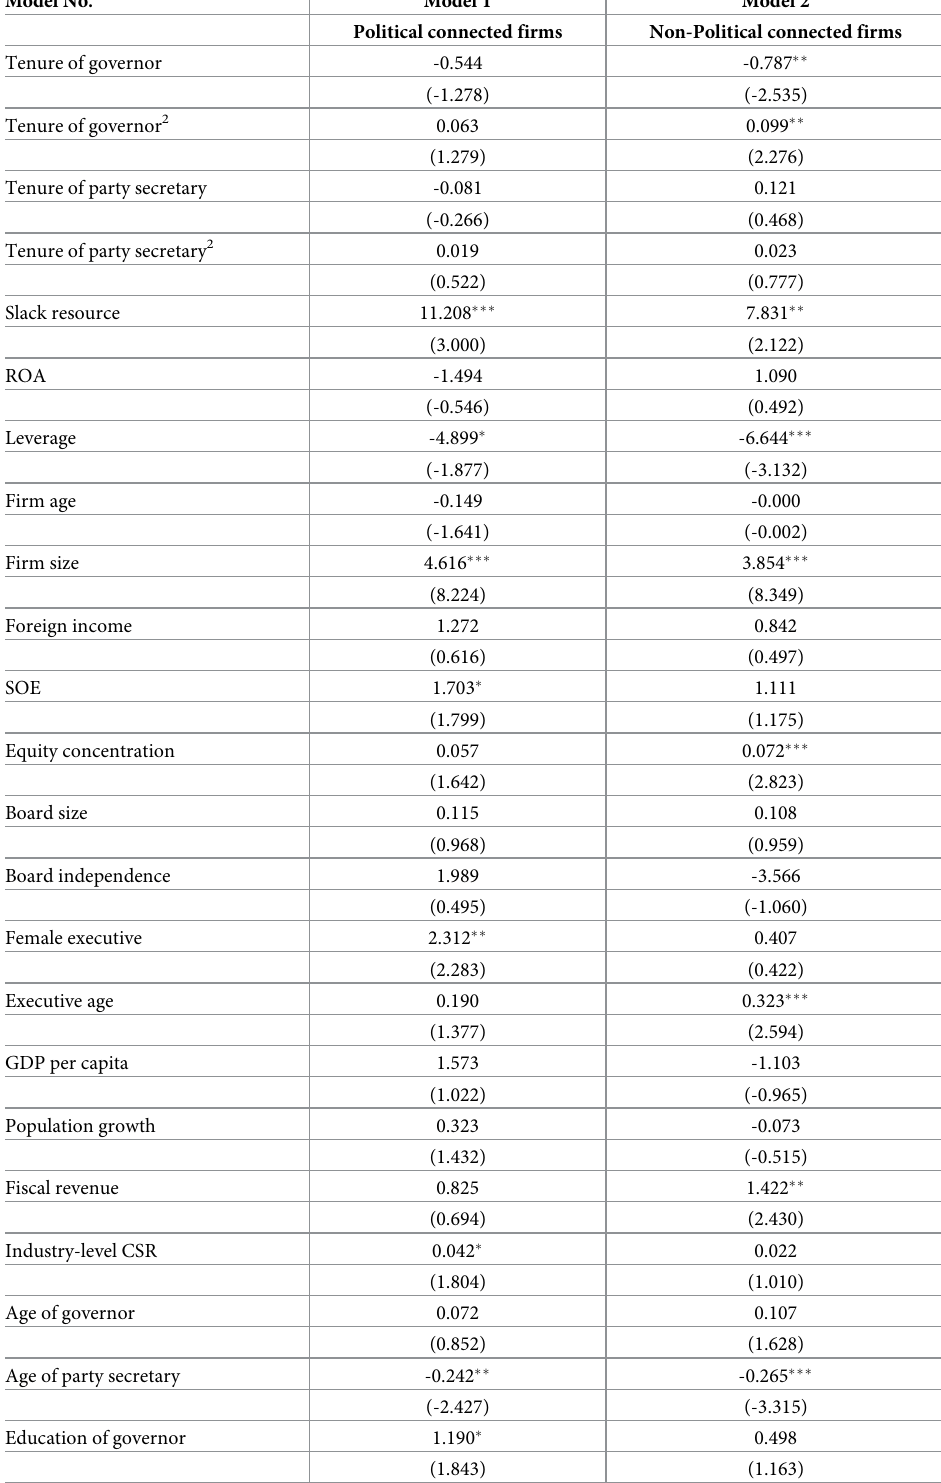
Table 8. The effect of firms’ political